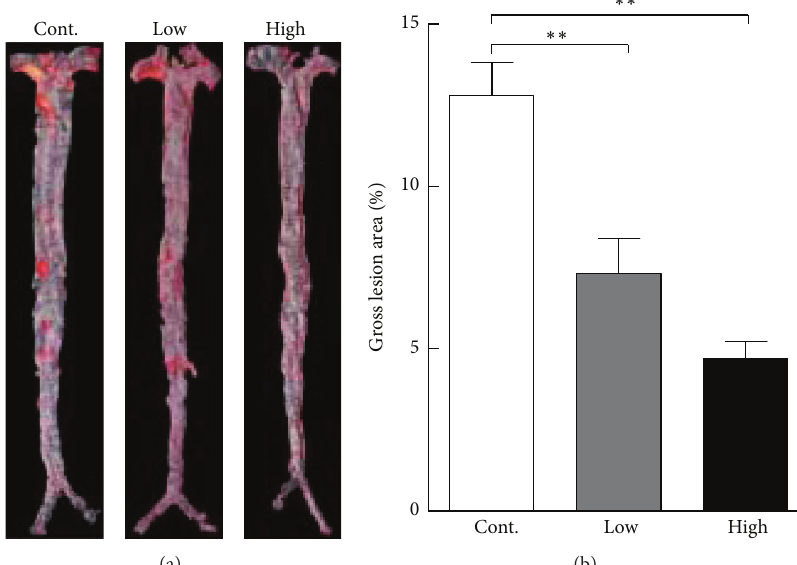
Figure 2: Representative picture of oil red O staining of aortas (a) and quantitative analysis of atherosclerotic lesions (b). Data are expressed as the mean ± SEM. 𝑛 = 12 for each group. ∗∗ 𝑃 < 0.01 versus